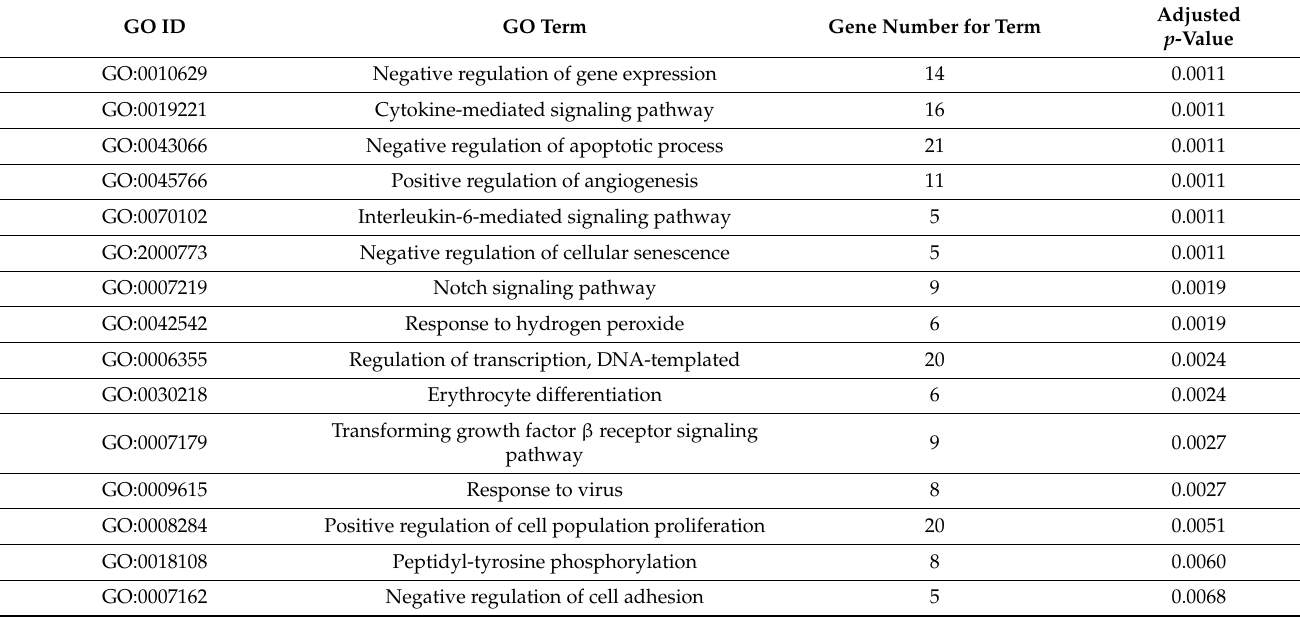
Table 3. The top 15 enriched GO terms across predicted targets of miRNAs with different levels in plasma and serum.